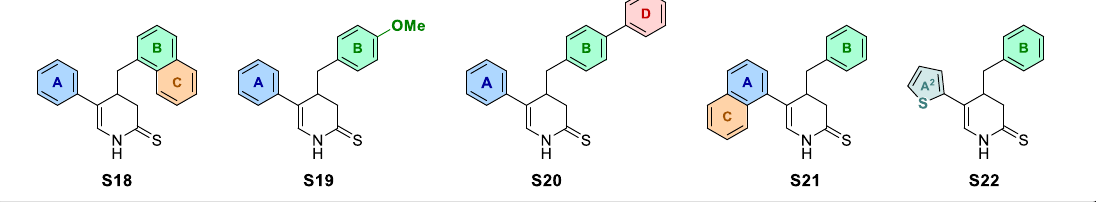
Figure 1. Compounds S1 - S22 obtained and tested within a three-step optimisation process.